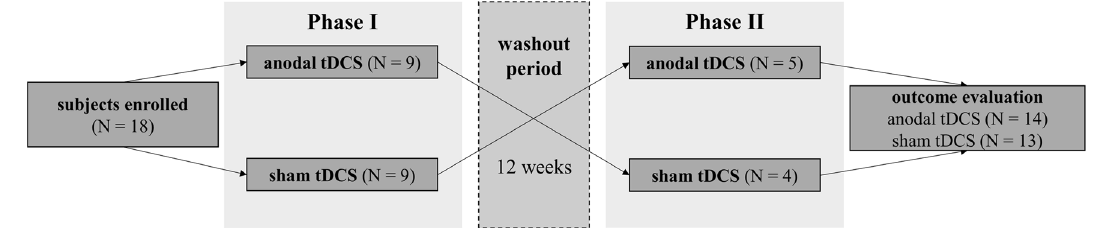
Figure 1. Schematic design of the study. A two-phased, randomized controlled, cross-over study with two groups [anodal and sham tDCS (transcranial direct current